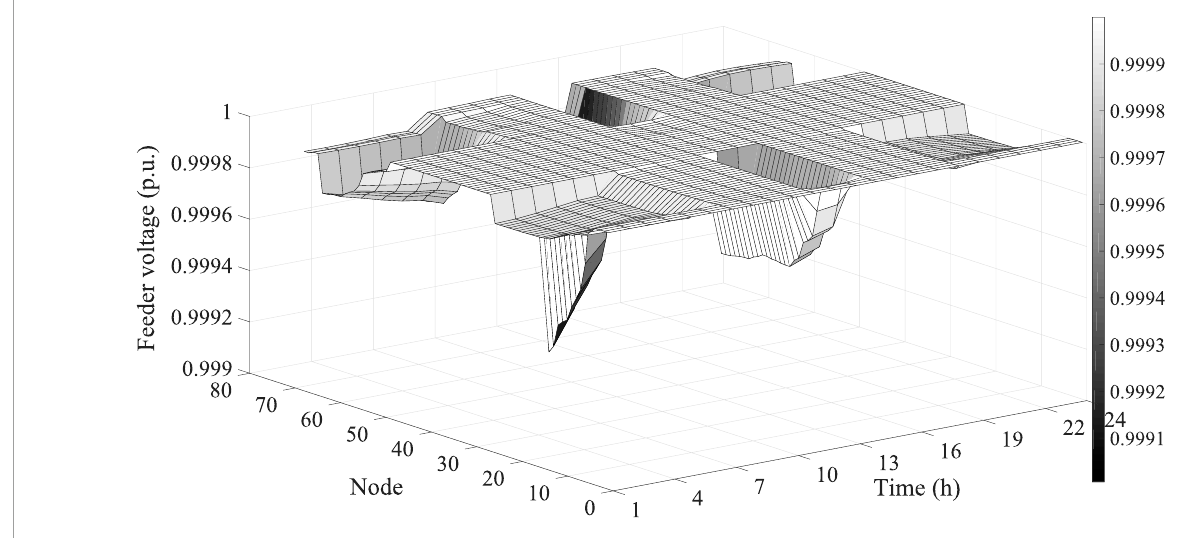
FIGURE 4 The feeder voltage of the test system over 24-h.